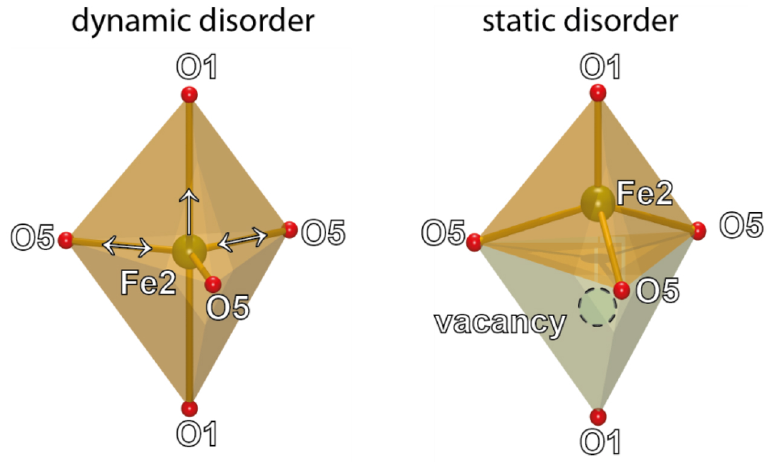
Figure 7. Theoretical models of arrangement of the Fe2 site in the barioferrite crystal structure. Arrows shows direction of the bond elongation. Minerals 2018 , 8 , x FOR PEER REVIEW